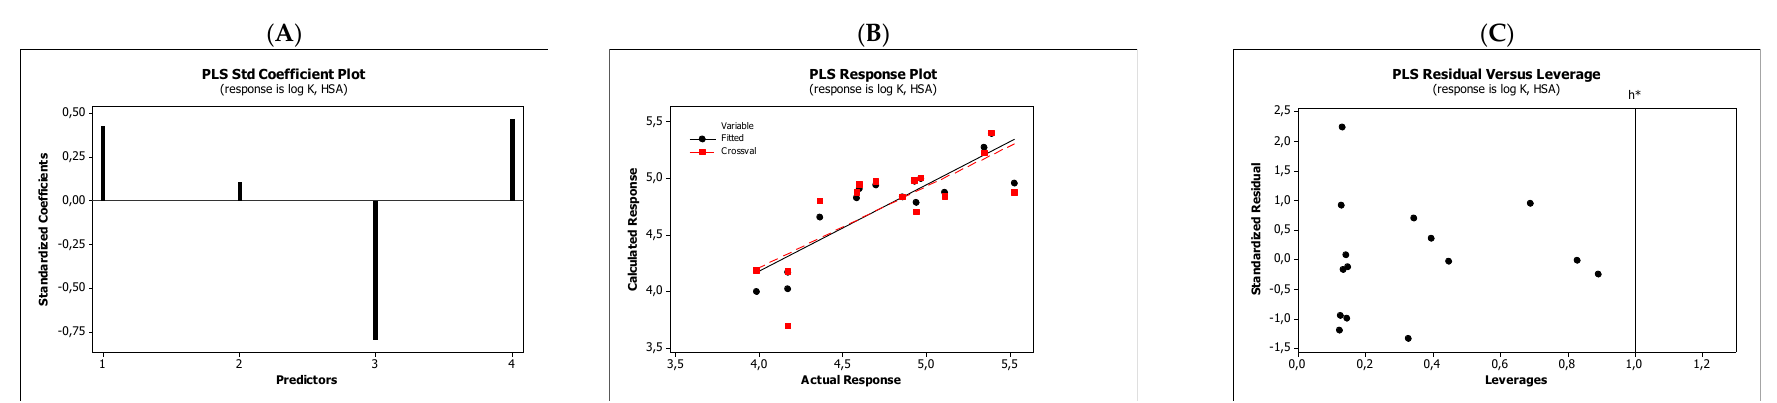
Figure 9. Standardized coefficients ( A ), the correlation between actual and predicted log K a, HSA parameters ( B ), and the Williams plots ( C ) of Equation (8).